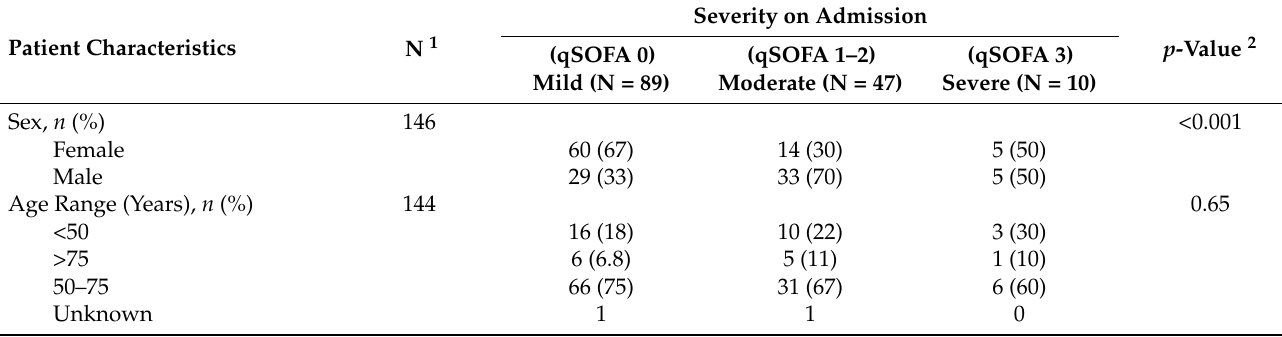
Table 1. Characteristics, demographics, and clinical observations of COVID-19